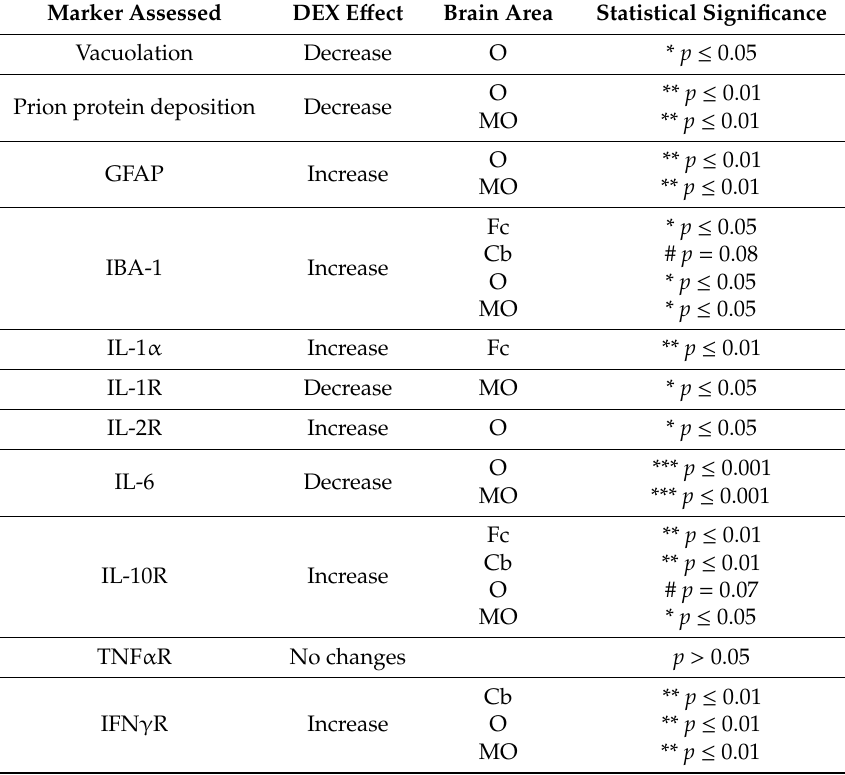
Table 1. Summary of statistical results obtained in this